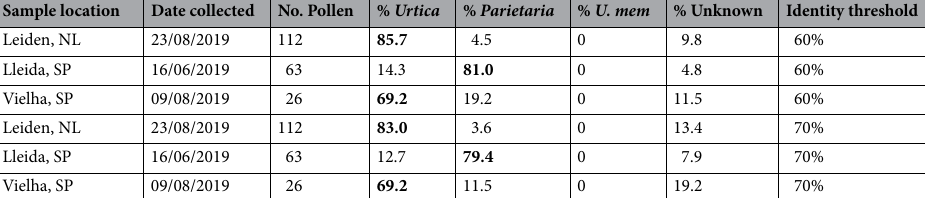
Table 2. Results of the deep learning model VGG16 on Urticaceae pollen from an area representing 10% of the total deposition area of Hirst-type aerobiological samples from Leiden (the Netherlands), Lleida and Vielha (both Catalonia, Spain). Values in bold represent the highest accuracy scores obtained for each of the three classes. The threshold for identification was tested at 60% and 70%. Images that were classified below this level were classified as unknown. U.mem = Urtica membranacea